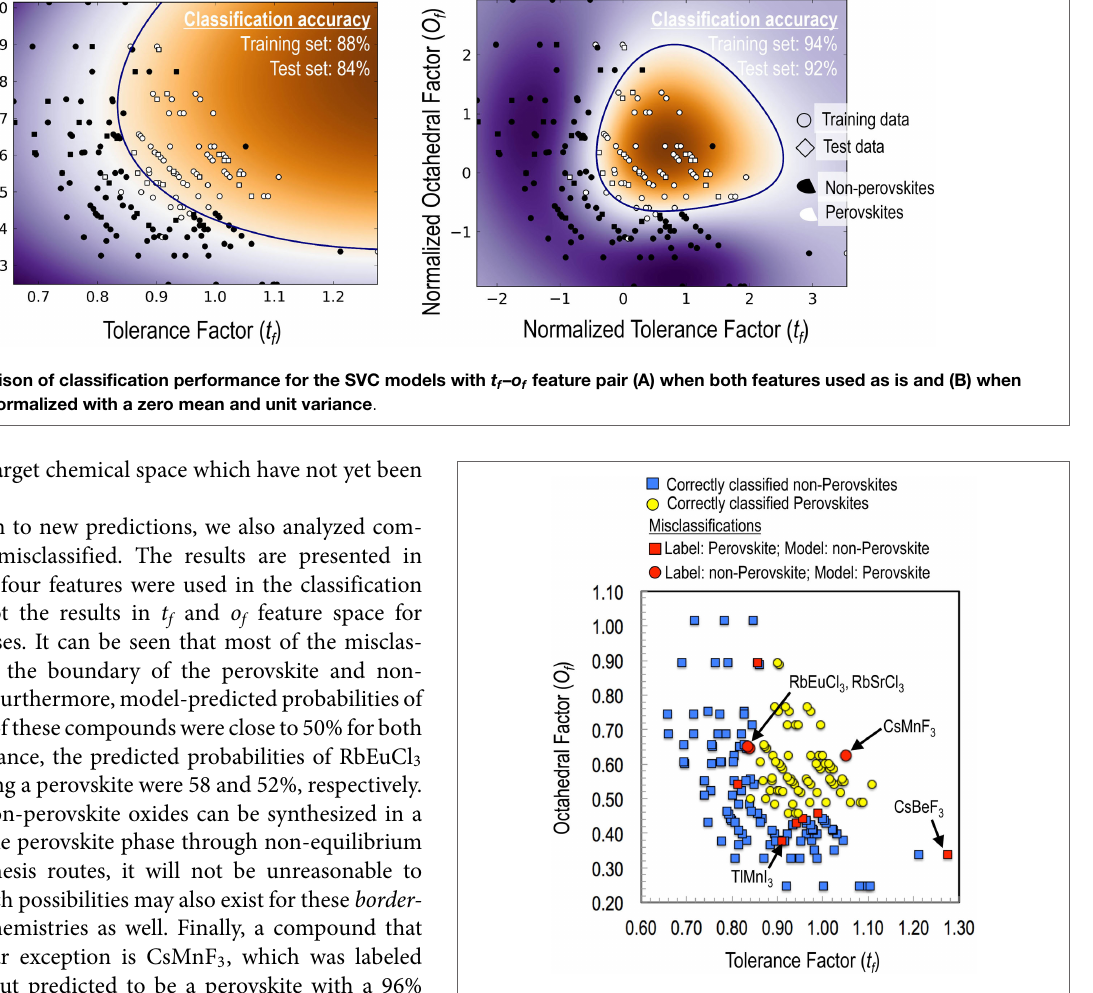
FIGURE 4 | Analysis of the training set misclassifications for the best performing model with Ω =4 (i.e., with features r i A , r i B , t f , and o f ) . While all of the four features were used in the classification model; here, the results are plotted in a two-dimensional plot with the t f and the o f for better